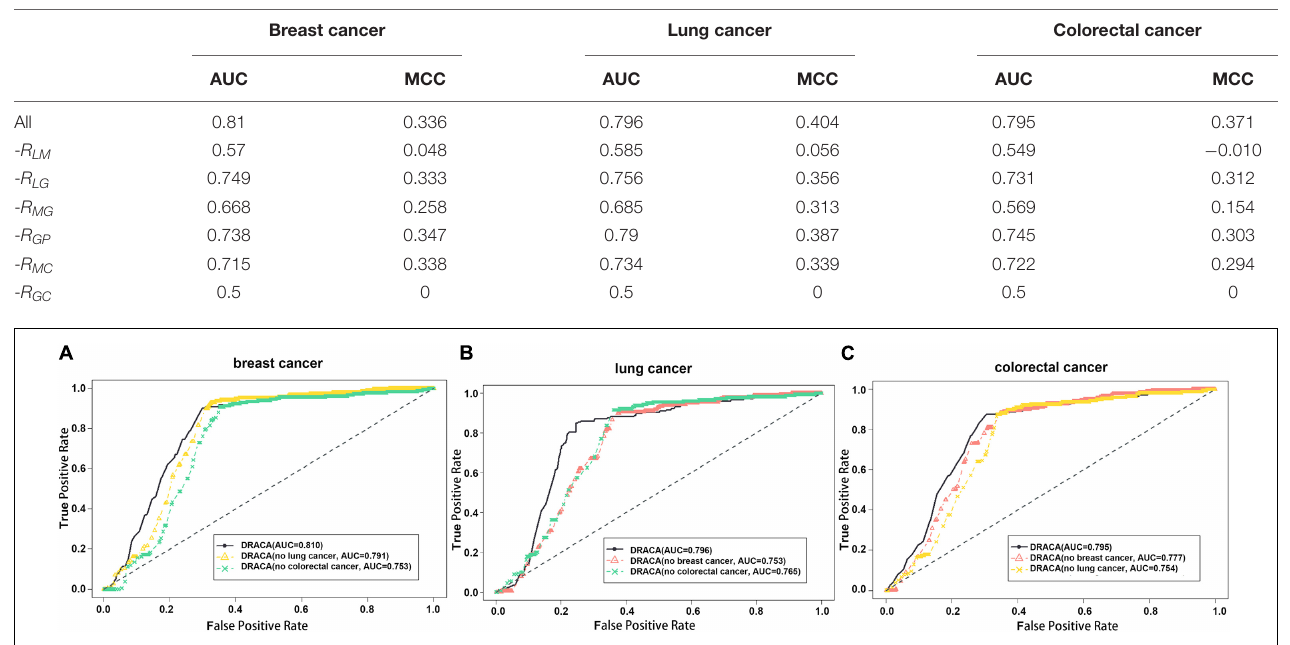
TABLE 3 | The AUCs and MCCs for DRACA predictions after removing the associations between features.